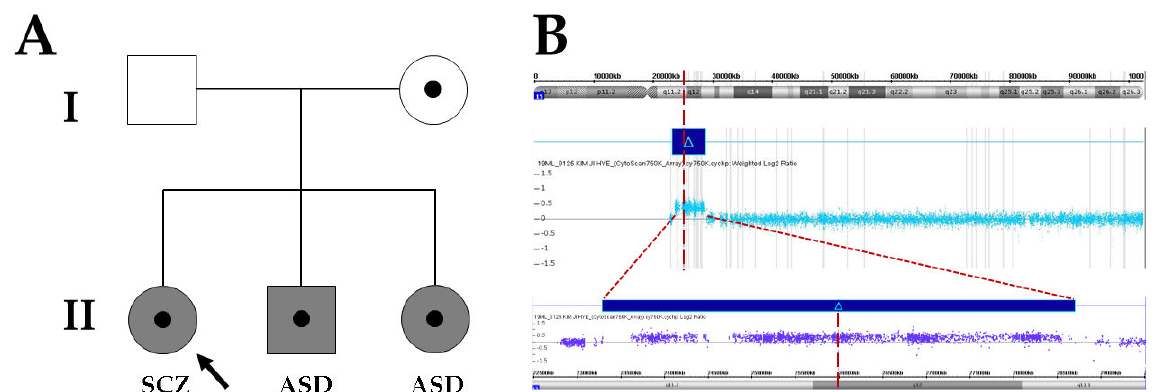
Figure 1. Pedigree analysis and array–comparative genomic hybridization in the proband. ( A ) Family pedigree depicting maternal origin of interstitial duplications at 15q11.2-q13.1 in a Korean family with schizophrenia and autism spectrum disorder. The grey symbol indicates affected individual. SCZ, schizophrenia; ASD: autism spectrum disorders. ( B ) Array– comparative genomic hybridization identifies interstitial duplications at 15q11.2-q13.1 between breakpoint 2 and 3 in the proband. The arr 15q11.2q13.1 (23,290,787_28,704,050) × 3 involving genes: ATP10A , GABRA5 , GABRB3 , GABRG3 , HERC2 , MAGEL2 , MKRN3 , NDN , NPAP1 , OCA2 , PWRN1 , PWRN2 , SNHG14 , SNORD115-1 , SNORD116-1 , SNRPN , and UBE3A